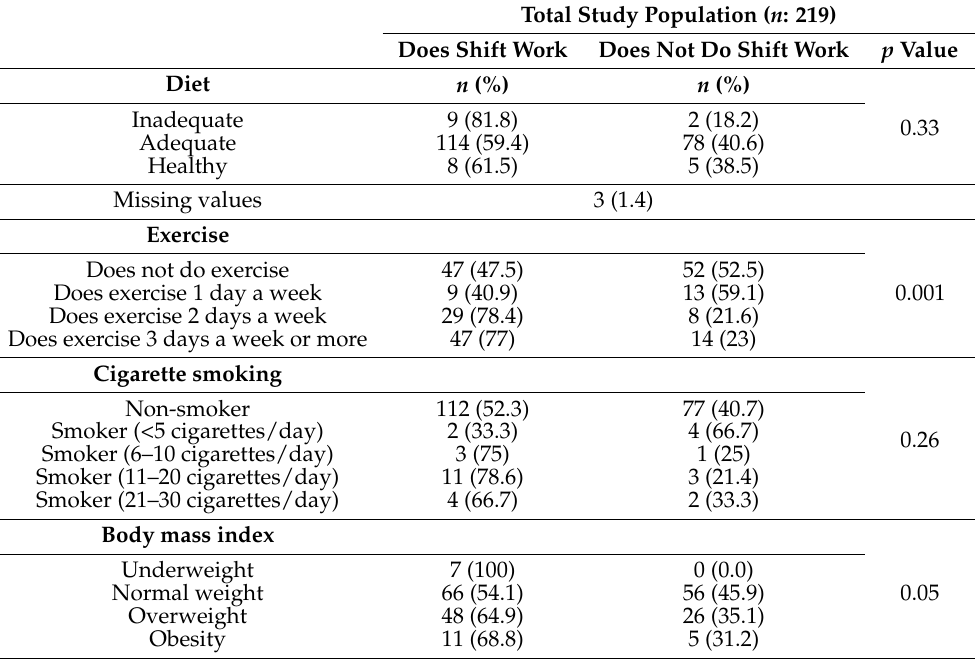
Table 3. Relationship between doing shift work and type of diet, physical exercise, tobacco consump- tion, and body mass index.